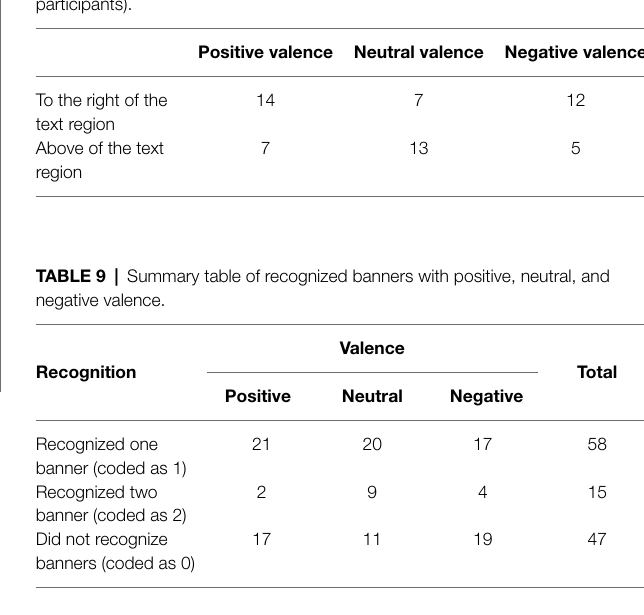
TABLE 8 | Summary table of found lateral and top (cells contain the number of participants).